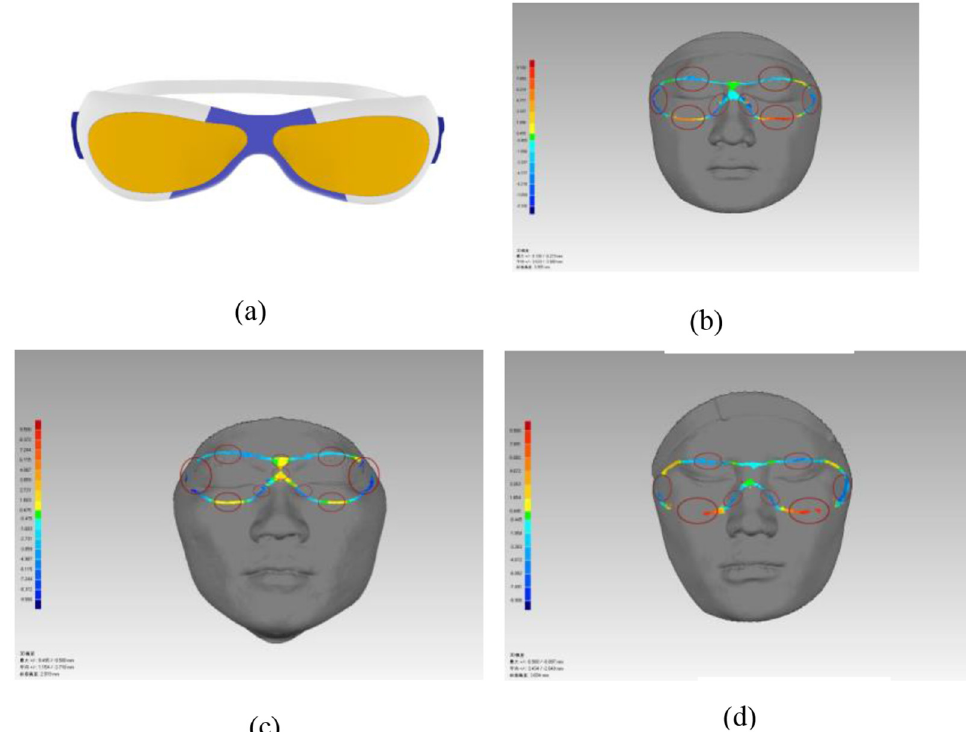
Fig. 5. Veri fi cation of the validity of feature point selection.